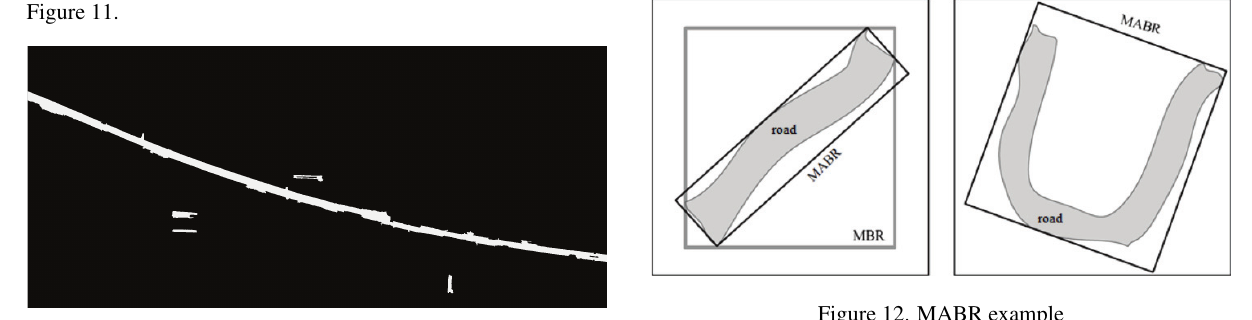
Figure 11. Result of road segments extraction